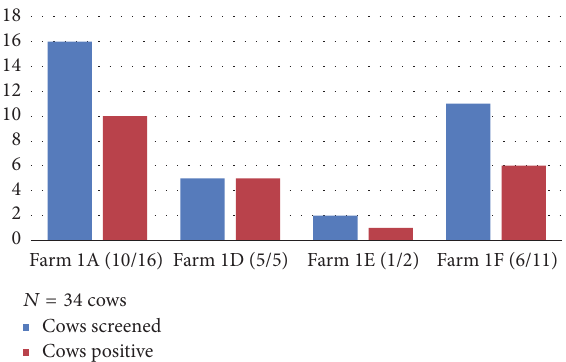
Figure 2: Proportion of cows that tested positive for mastitis on each farm in Kashongi subcounty.